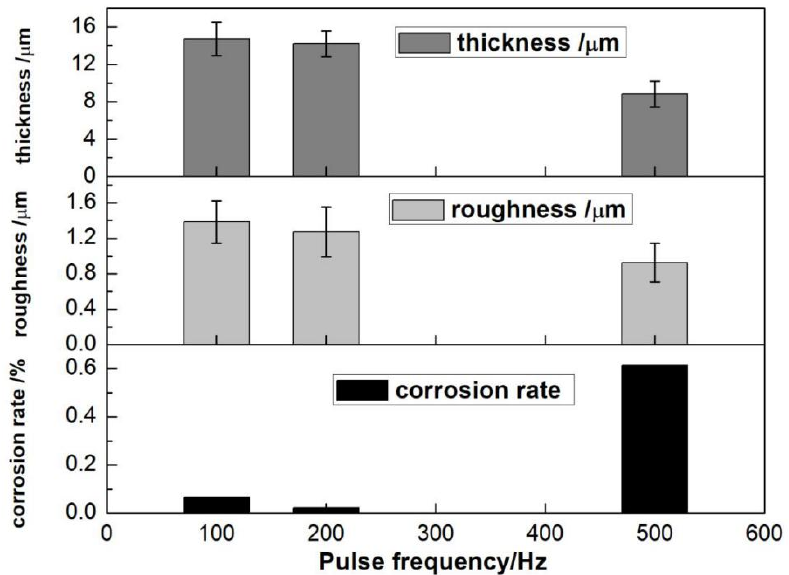
Figure 4. The values of corrosion rate, roughness and thickness at different pulse frequencies. Electrolyte compositions: 45 g/L NaOH, 50 g/L Na 2 SiO 3 , 90 g/L Na 2 B 4 O 7 . Electrical parameters: current density 1 A/dm 2 ; oxidation time 10 min; duty cycle 10%.